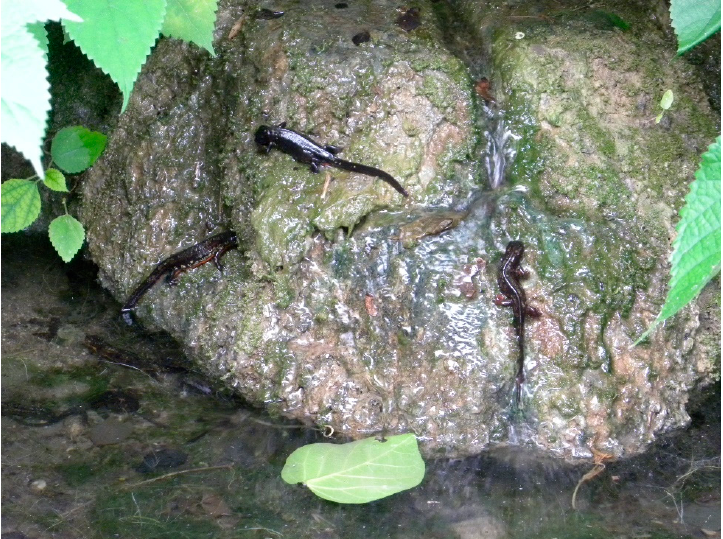
Figure 4. Sacred biodiversity? Salamanders frolicking in the Ur ō k ā sacred spring next to S ē fa Utaki. However, throughout Okinawa, invader species pose a serious threat to endemic plants and animals. This is one of the main problems of Yanbaru National Park, home to a number of